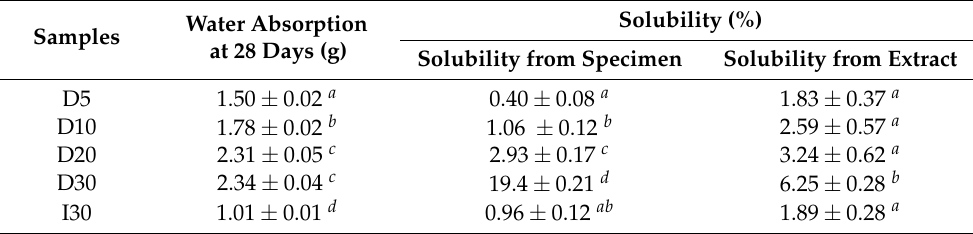
Table 2. Water absorption and solubility of the samples (mean ± SD). Samples